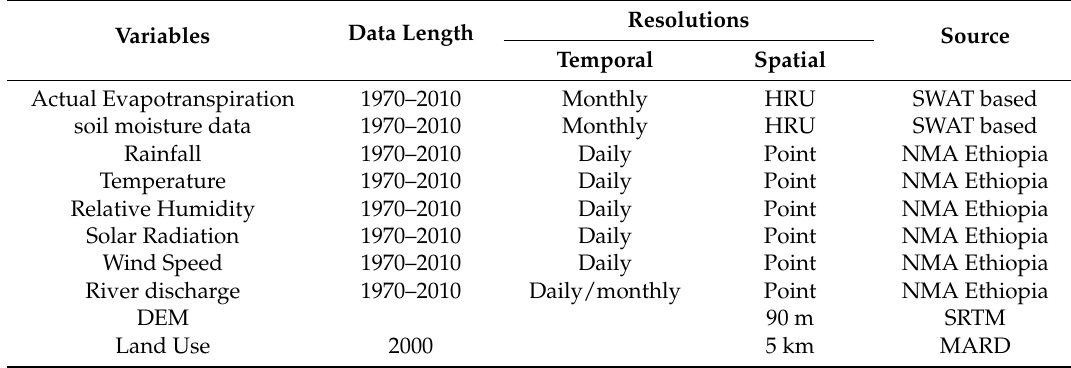
Table 2. Summary of the input data used in this